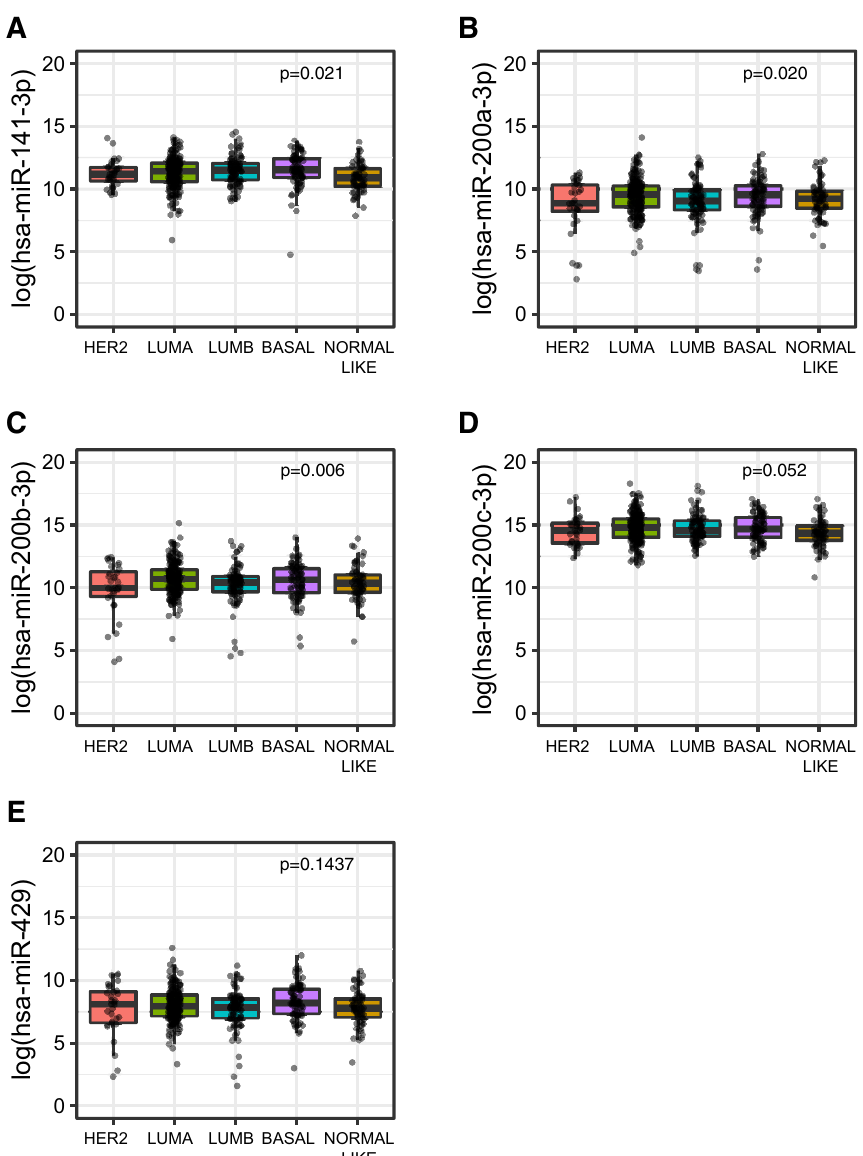
Figure 4. miR-200 family members differential expression within the intrinsic molecular classification subgroups in the TCGA-BRCA cohort: HER2 enriched tumors (HER2), Luminal A (LUMA), Luminal B (LUMB), Basal like, and NORMAL LIKE tumors. Plots were performed using the R Foundation for Statistical Computing (version 3.6, packages: ggplot2, gridExtra).